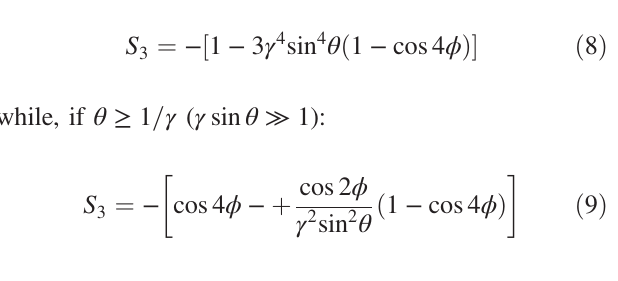
FIG. 3. Distribution of the radiation intensity along x (red) and y